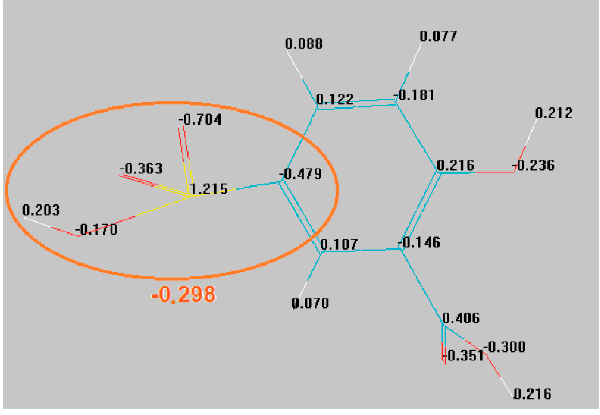
Figure 9. The simulation results of the electrical charge distribution inside the SSA molecule.